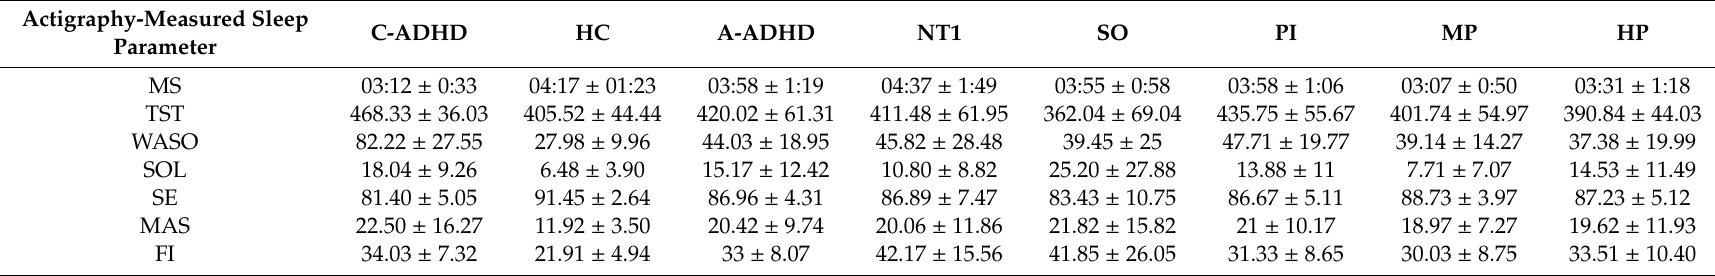
Table 1. Means and standard deviations of actigraphy-measured sleep parameters of di ff erent groups of patients and healthy controls, listed in increasing order of average